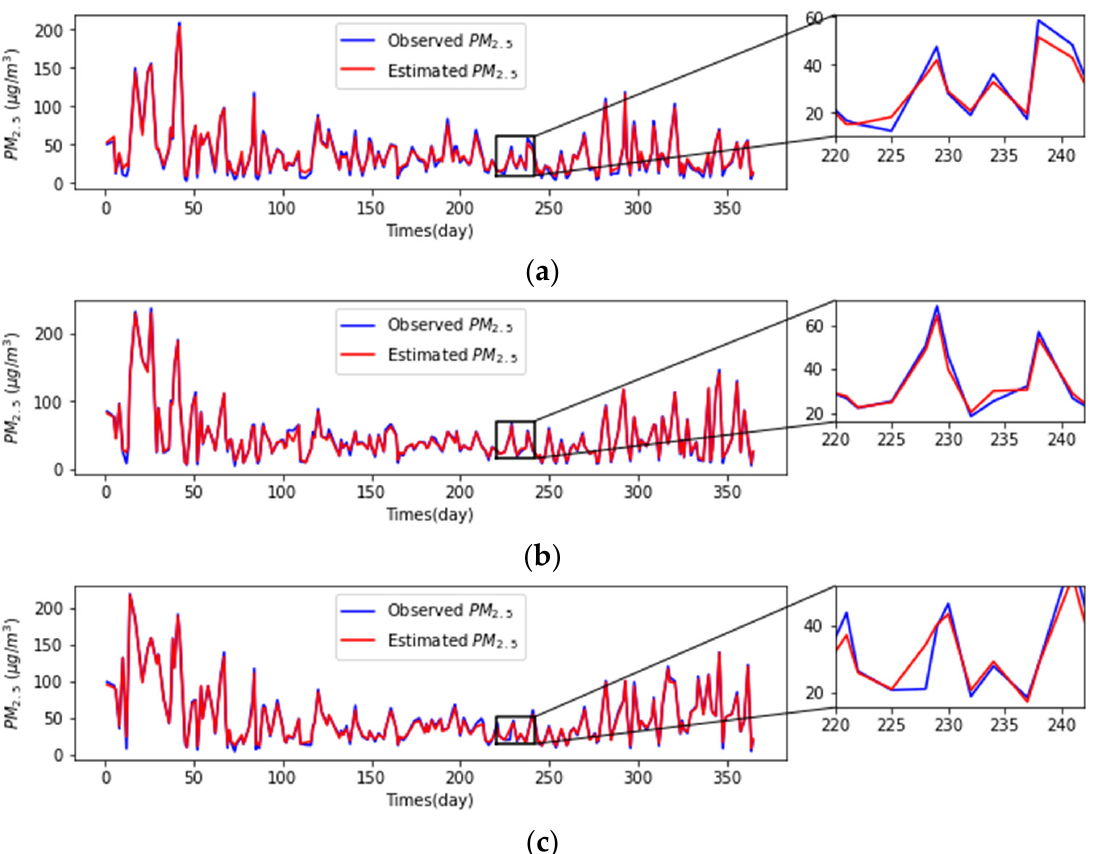
Figure 9. Time series of observed (blue) and estimated (red) daily PM 2.5 concentrations in 2020. ( a ) Beijing, ( b ) Tianjin, and ( c ) Shijiazhuang.